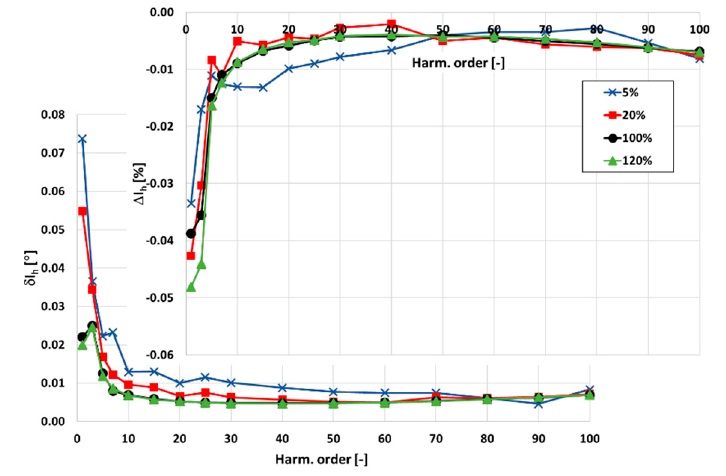
Figure 3. The values of current and phase errors at harmonics of the developed wideband CT for secondary current 1 A, rated load, and 5%, 20%, 100%, 120% of rated primary